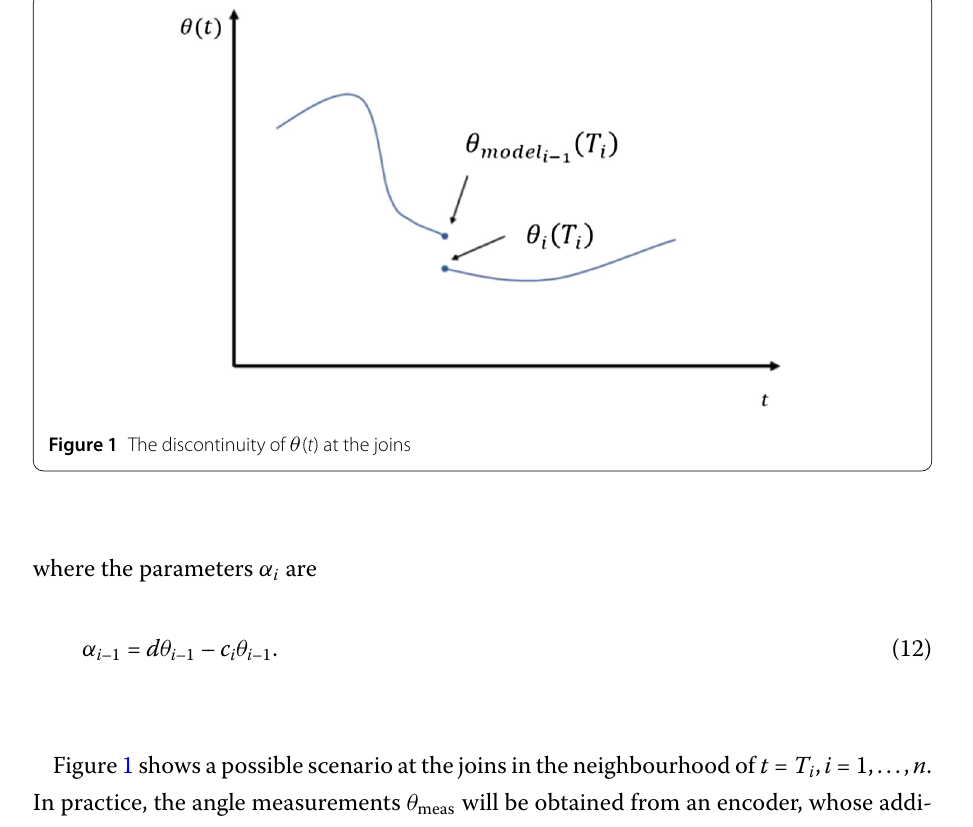
where the parameters α i